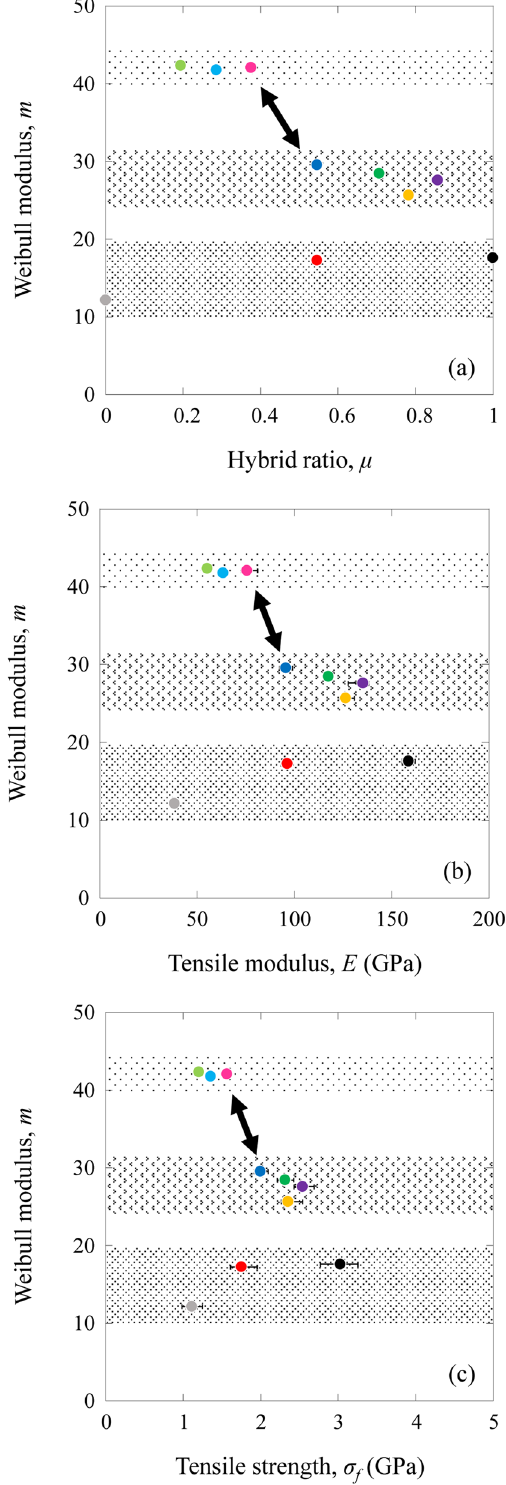
Figure 6. Weibull modulus of HFRP specimens as a function of hybrid ratio and tensile properties. ( a ) Hybrid ratio, ( b ) tensile modulus, and ( c ) tensile